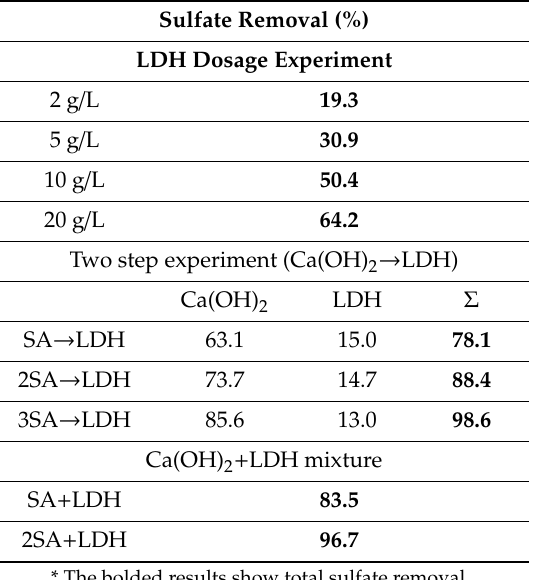
Table S1: The concentration of elements in the AMD water before and after treatment with SA + LDH measured with inductively coupled plasma-optical emission spectrometer (ICP-OES) / mass spectrometry